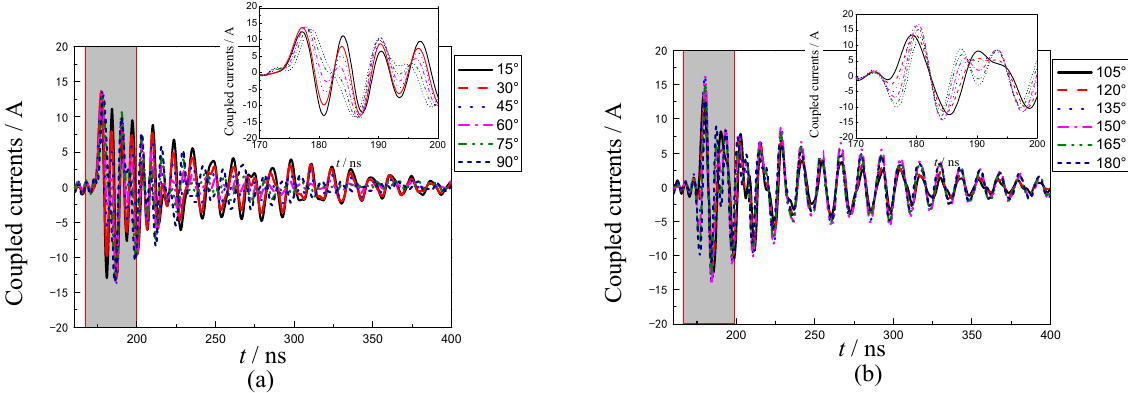
Figure 6. The coupled currents calculated linearly to 50 kV/m of the incident field: ( a ) 0 ◦ to 90 ◦ ; ( b ) 90 ◦ to 180 ◦ . The values calculated by different norms with a different polarization direction θ of the waveform are shown in Table 2. In the verification, the maximum values of the norms in Table 2 are served as the maximum couplings. For example, the maximum infinity norm of the entire coupling is 16.8